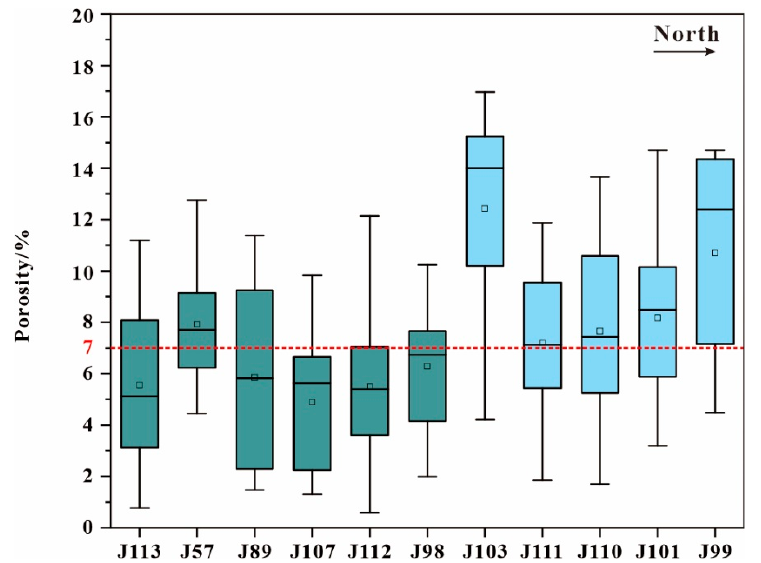
Figure 8. Boxplot of porosity of Lower Shihezi Formation tight sandstones in the Duguijiahan block, Ordos Basin.